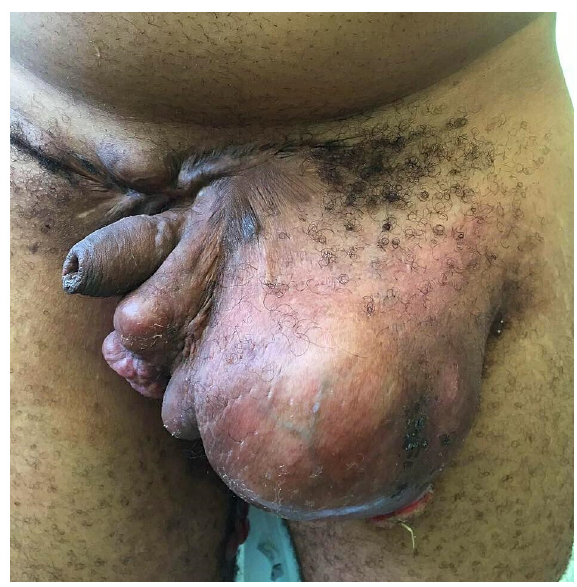
Figure 1. Recurrent inguinal low grade fibromyxoid sarcoma involving scrotum in a 38-year-old patient.